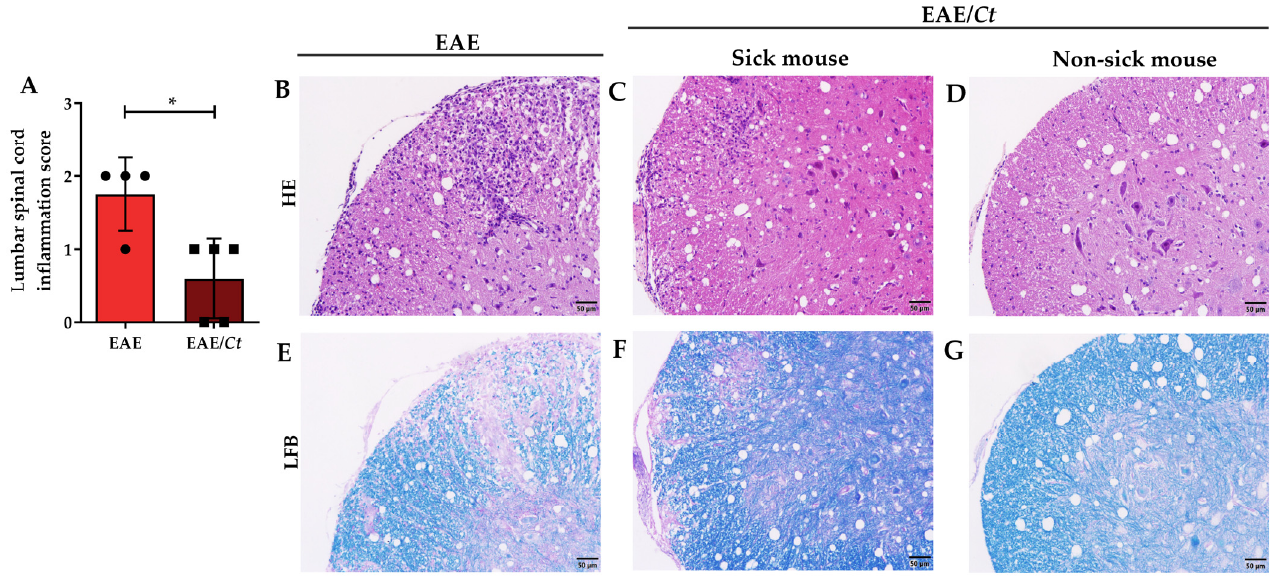
Figure 6. Effect of C. tropicalis infection on neuroinflammation in EAE mice. Female C57BL/6 mice were infected with 1 × 10 6 viable C. tropicalis yeasts three days before EAE induction and evaluated for inflammatory infiltrate ( A – D ) and demyelination ( E – G ) in the lumbar spinal cord. Representative images of each group. The results are expressed as mean ± SD; * p < 0.05.